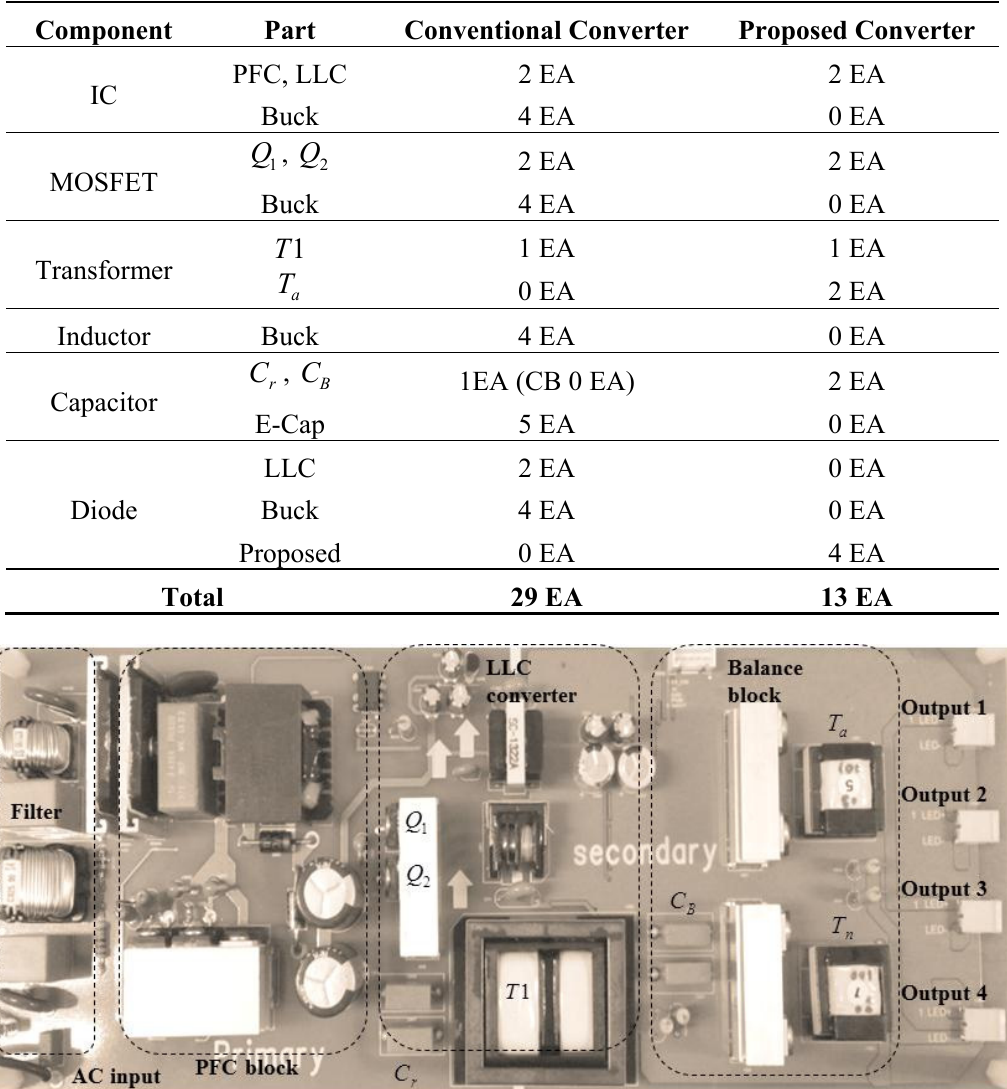
Table 2. Comparison between the proposed converter and a conventional converter.